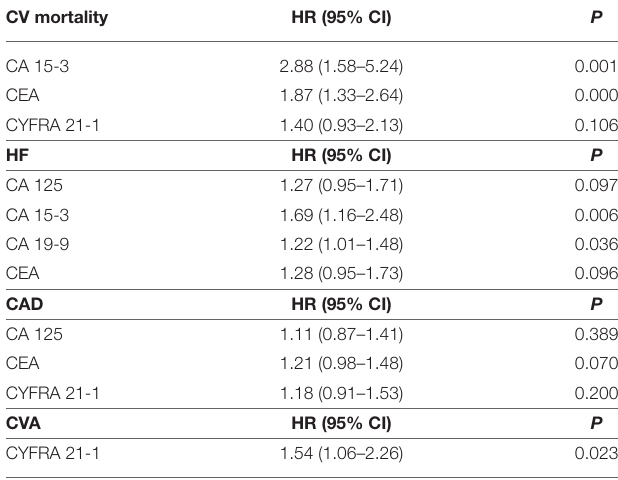
TABLE 7 | Correlation of tumour biomarker levels and CV mortality, HF, CAD, and CVA. CV